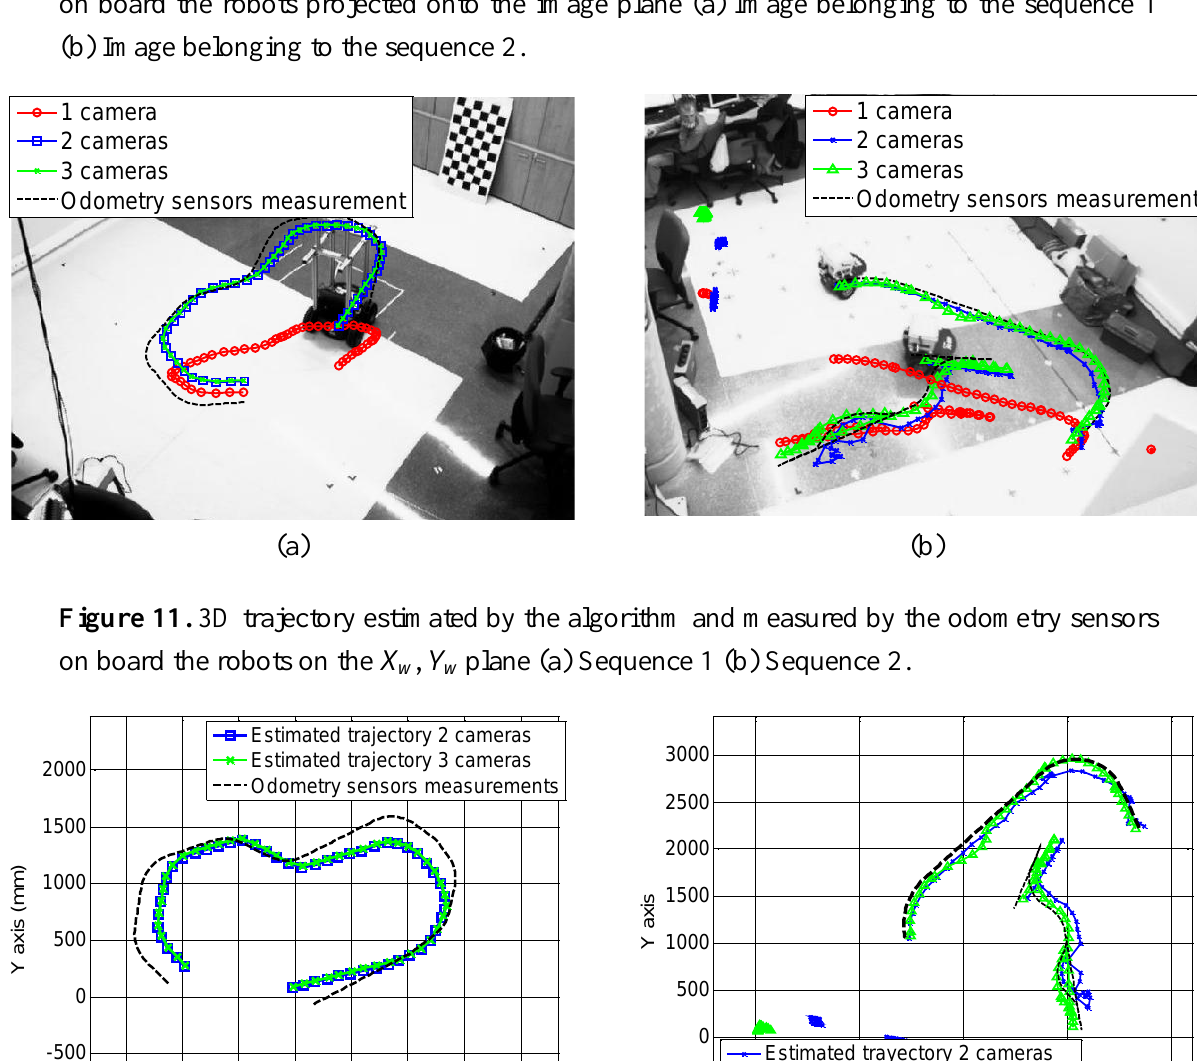
Figure 10. 3D trajectory estimated by the algorithm and measured by the odometry sensors on board the robots projected onto the image plane (a) Image belonging to the sequence 1 (b) Image belonging to the sequence 2.